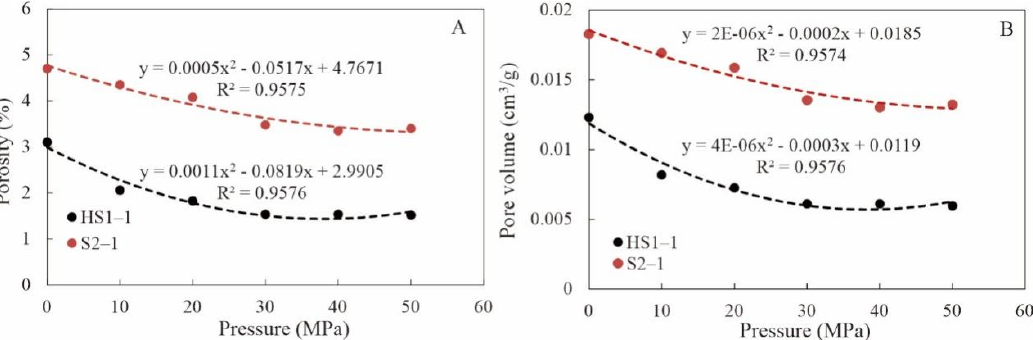
Figure 3. Porosity ( A ) and pore volume variations ( B ) under the overburden pressure of 0–50 MPa.